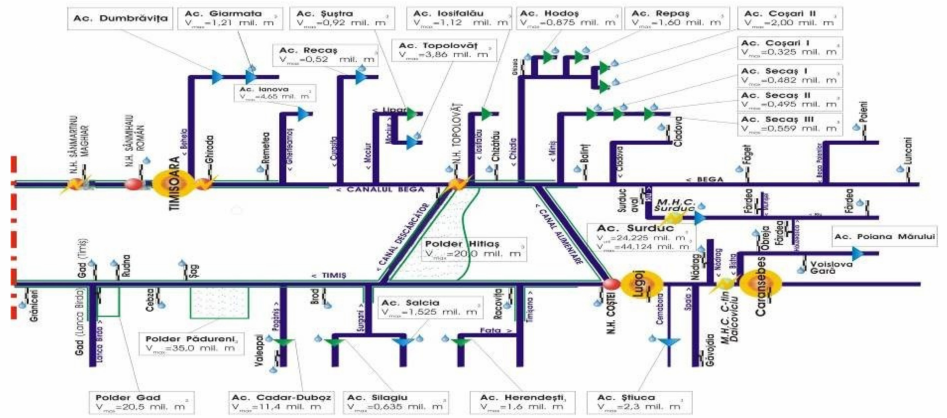
Figure 8. Timis -Bega interconnection—synoptic scheme (A.B.A. ,